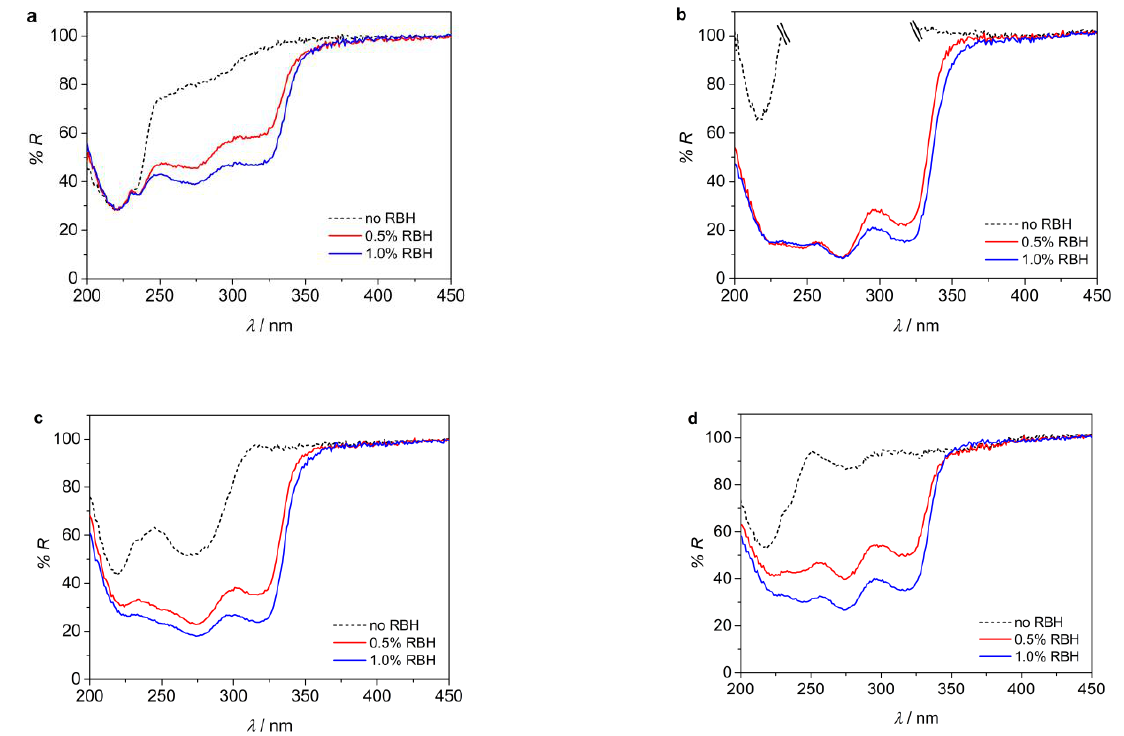
Figure 6. Reflectance spectra of samples with 0, 0.5, and 1% ( w / w ) post-loading of RBH: ( a ) casted film, ( b ) phase deposited membrane § , ( c ) fibers from DMF, and ( d ) fibers from DCM / acetone. Emission spectra have been collected, upon excitation at 320 nm, for all samples (Figure S4). The